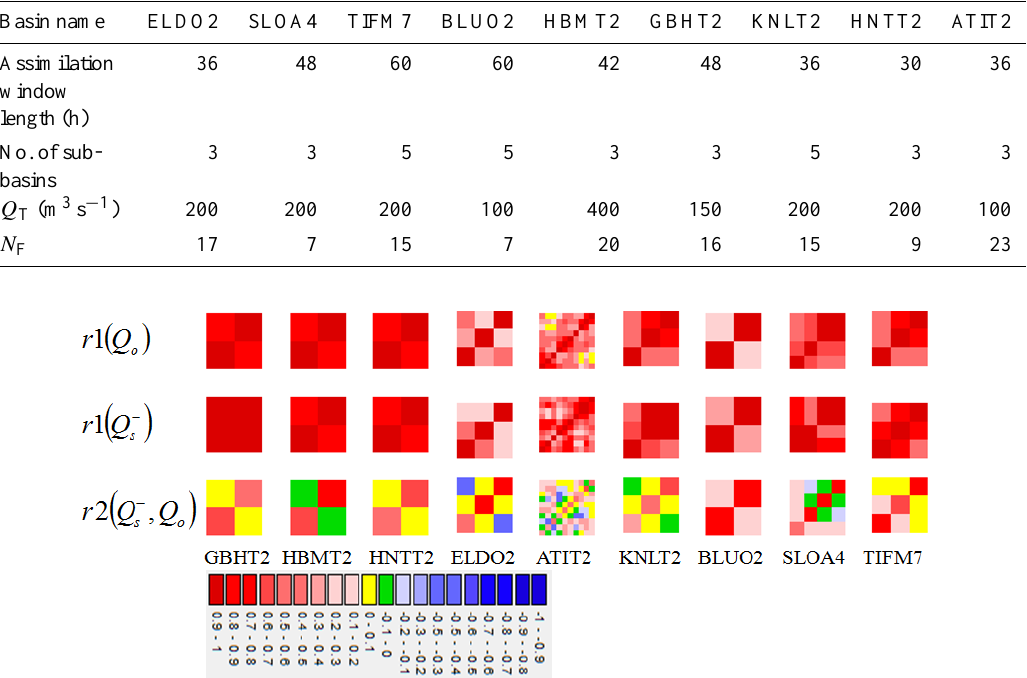
Fig 4. Spatial correlation structure of the streamflow processes. 814 Fig. 4. Spatial correlation structure of the streamflow